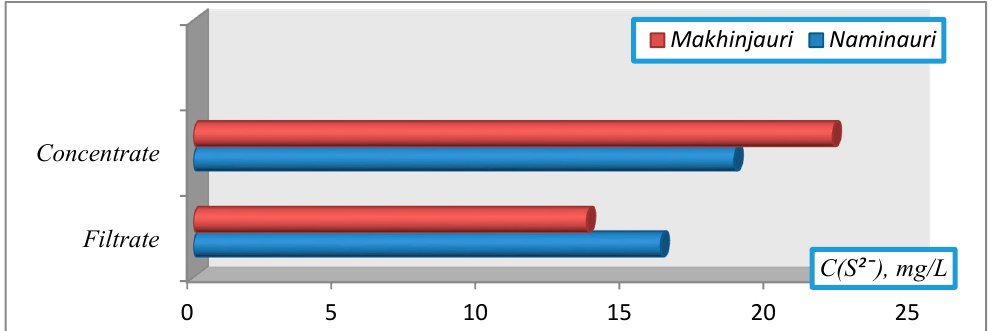
Figure 7. Change in the content of sulfide ions during ultrafiltration of Naminauri and Makhinjauri mineral waters.